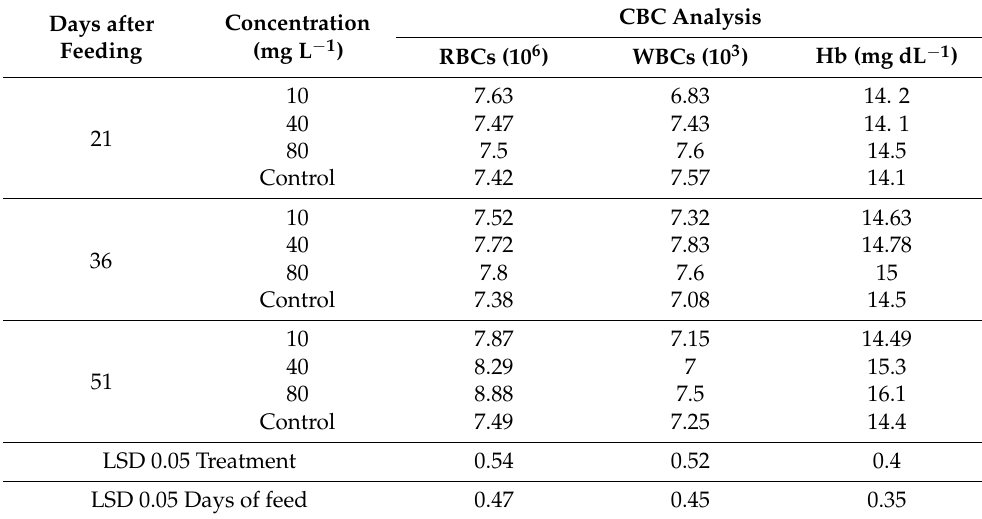
Figure 5. Activity of catalase in grain sorghum plants uninfected ( A ) and infected with A. striticum ( B ) in response to application of Fe 3 O 4 /HA NPs. Same letter in the figure means no significant differences between the values. Table 8. Hematological attributes of male albino rats fed on grain sorghum treated with Fe 3 O 4 /HA